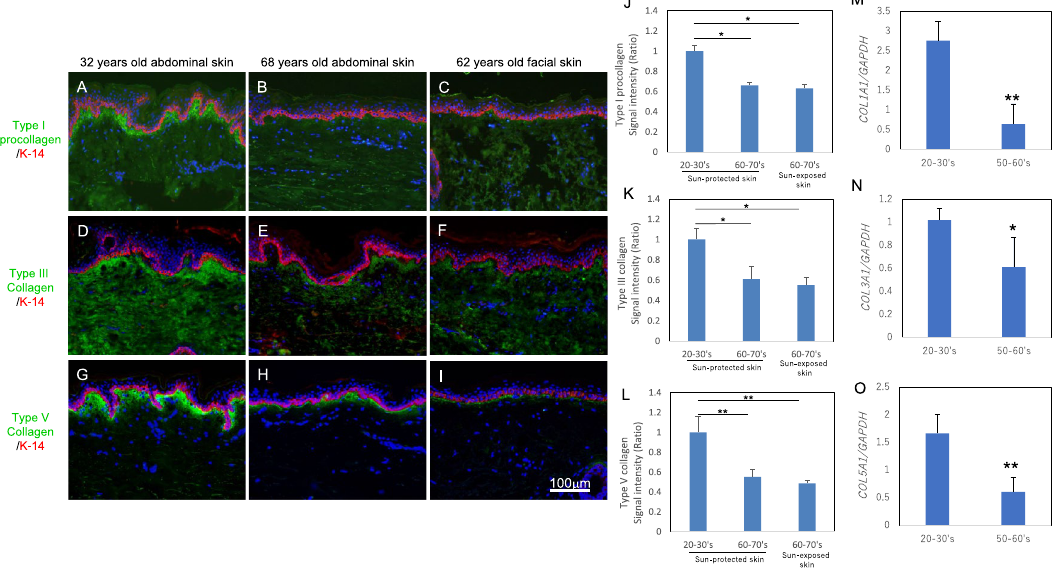
Figure 1. Age-dependent change of collagen fibrils in dermis. Immunostaining of type I procollagen ( A–C ), type III collagen ( D–F ) and type V collagen ( G–I ) in sun-protected young skin ( A, D, G ), sun-protected older skin ( B, E, H ) and sun-exposed older skin ( C, F, I ). Bars: 100 μm. Staining signal intensities of type I procollagen ( J ), type III collagen ( K ) and type V collagen ( L ) were analyzed using WINROOF 2015 image-analyzing software (Mitani, Fukui, Japan, https:// www. mitani- visual. jp/ produ cts/ image_ analys_ ismea sure- ment/ winro of/). Data are the means ± SD of six images from six donors each in the 20–30’s and 60–70’s. * p < 0.05, ** p < 0.01. mRNA expression levels of COL1A1 ( M ), COL3A1 ( N ) and COL5A1 ( O ) genes in cultured human fibroblasts from young and older donors were analyzed by qPCR. Data are the means ± SD of three independent experiments from six donors. *p < 0.05, **p <